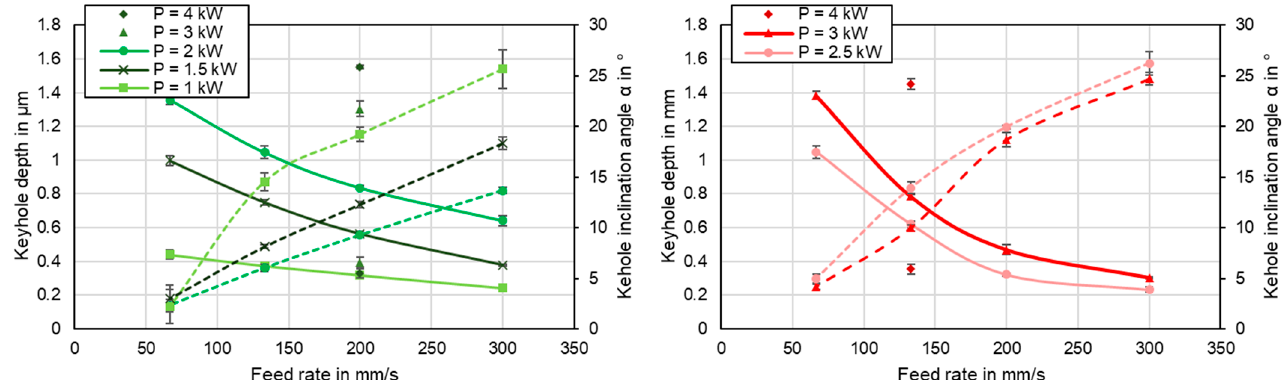
Figure 10. Keyhole depth and front wall inclination angle versus feed rate for selected laser powers using 515 nm ( left ) and 1030 nm ( right ) laser radiation